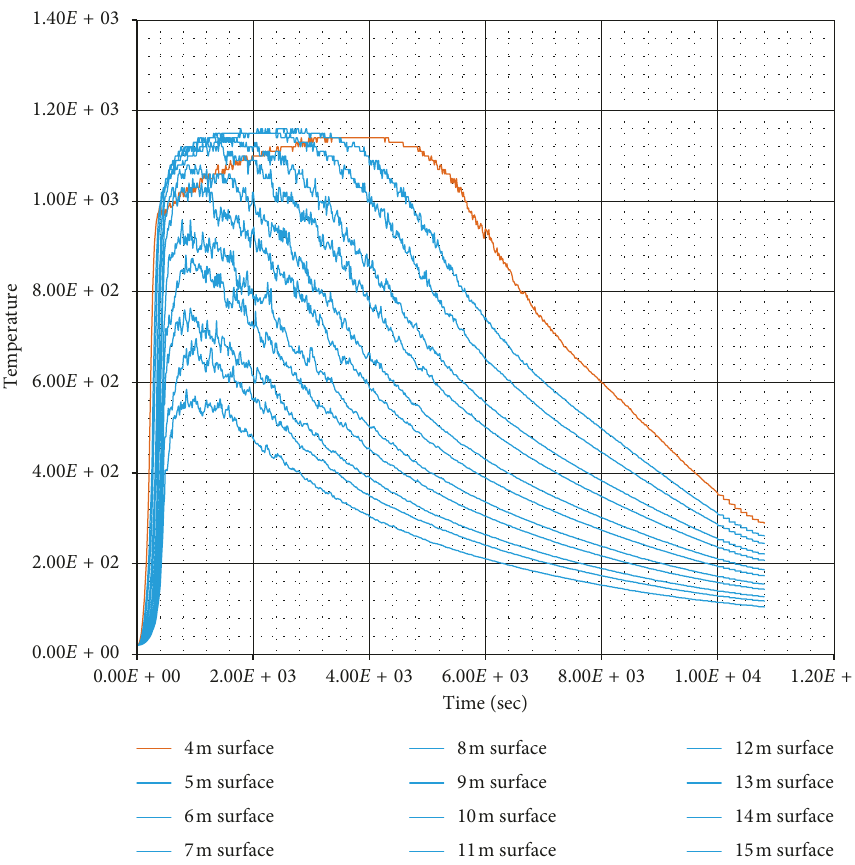
Figure 5: 130MW concrete bridges temperature-time curve. Table 1: Maximum surface temperature of concrete bridges according to mobilization time criteria and vertical clearance (130MW). Unit: ° C. Mobilization time criteria for fire suppression (min)